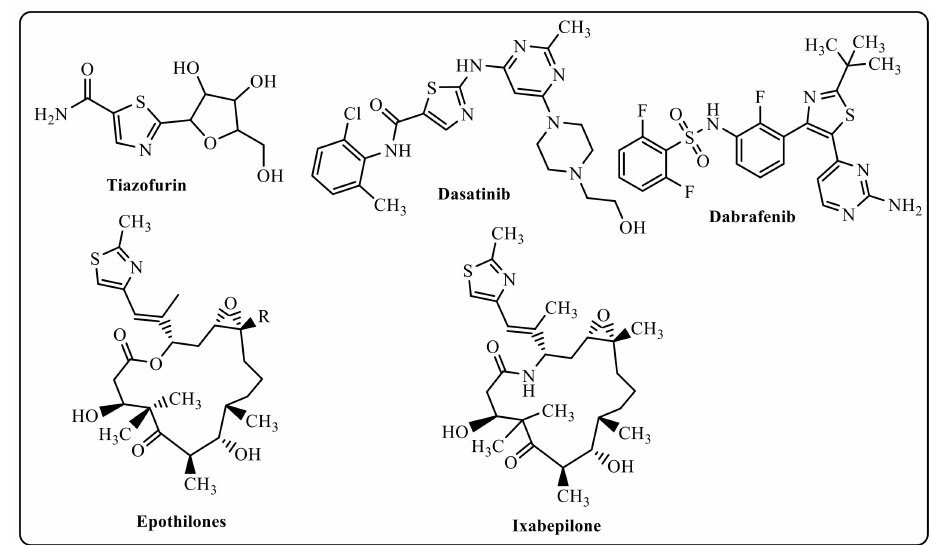
Figure 1. Examples of thiazole-bearing anti-cancer